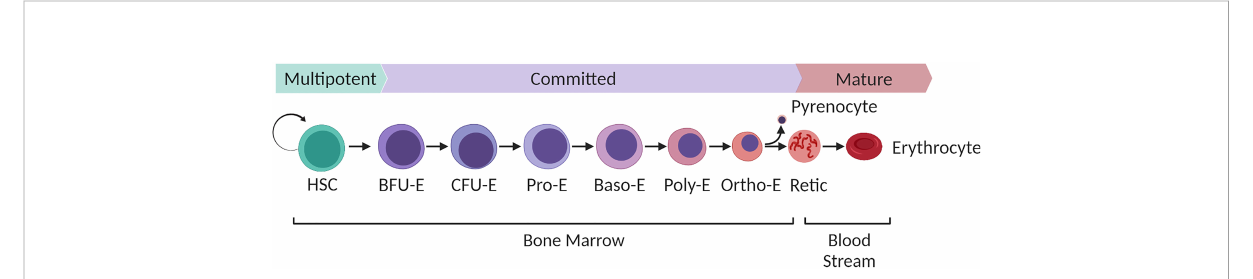
FIGURE 1 Overview of human bone marrow adult de fi nitive erythropoiesis. Multipotent haematopoietic stem cells with long term self-renewal capacity differentiate along a continuum of cell stages de fi ned by their expansive capacity, degree of commitment to the erythroid lineage and morphological characteristics as illustrated. Burst forming units (BFU-E), the earliest committed erythroid cells expand predominantly in response to stem cell factor with the combined synergistic in fl uence of erythropoietin driving continued proliferation of Colony forming units (CFU-E). Terminal differentiation of resultant proerythroblasts to enucleated reticulocytes takes place within the bone marrow niche